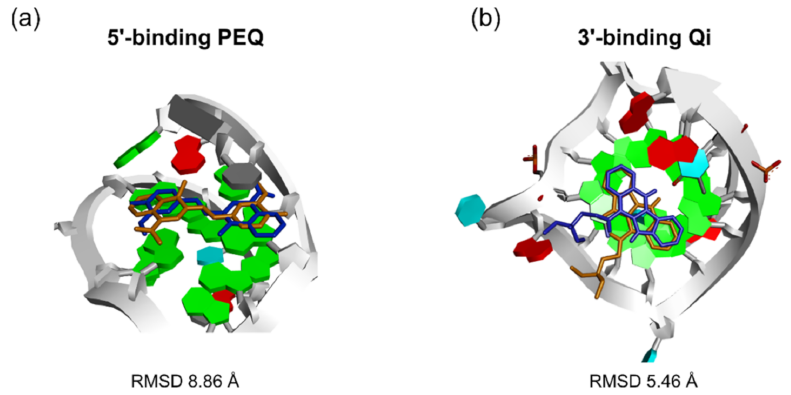
Figure 7. Examples of top poses from Glide SP (blue) in which the ligand was flipped 180 ◦ relative to the NMR poses (orange). ( a ) Top scored pose of 5 (cid:48) -end PEQ complex superimposed onto the NMR pose. ( b ) Top pose of 3 (cid:48) -end Qi complex superimposed onto the NMR